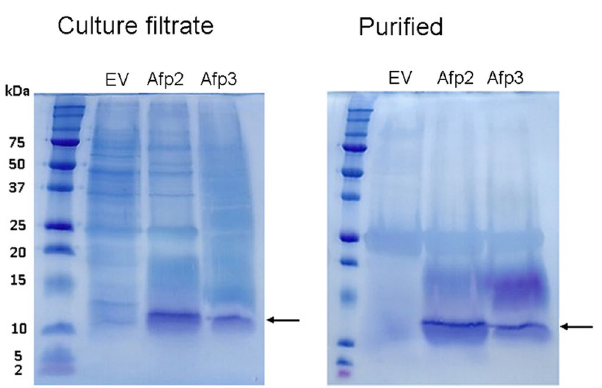
Figure 4. Expression of the Efe - afpA -2 and Efe - afpA -3 constructs in P . pastoris . SDS-PAGE of proteins in the methanol-induced P . pastoris culture filtrates and the partially purified Efe -AfpA-2 and Efe -AfpA-3 proteins. Arrows indicates Efe -AfpA proteins. EV, proteins from the empty vector control transformant; Afp2, proteins from the Efe - afpA -2 longer form construct; Afp3, proteins from the Efe - afp A-3 mature form